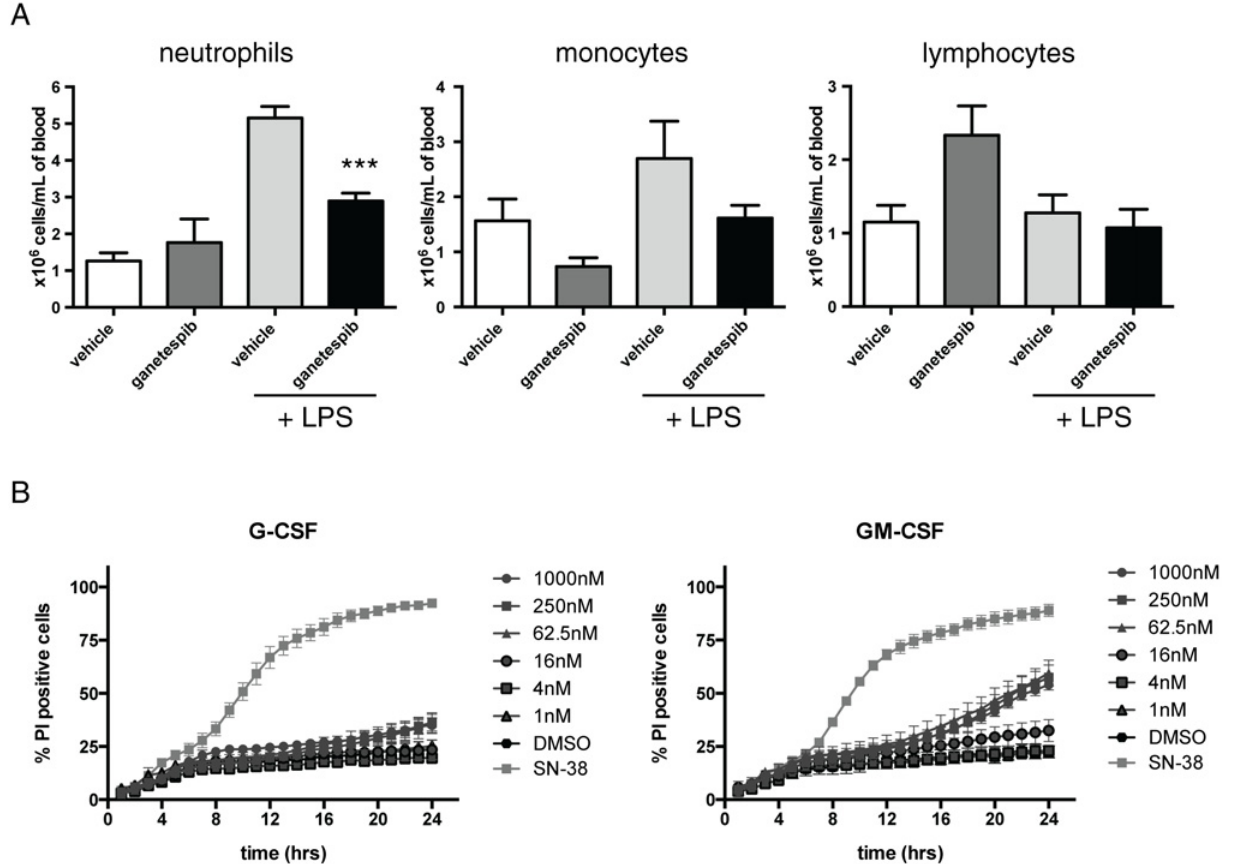
Figure 4. Ganetespib does not suppress basal circulating blood neutrophils but inhibits LPS induced mobilization without causing neutrophil apoptosis. Balb/c mice were treated with ganetespib (100 mg/kg, i.v. or vehicle) and challenged with LPS (10 µ g/mouse tn). (A) 24 h post-LPS peripheral blood counts and blood smears were obtained. Smears were manually differentiated into neutrophils, monocytes and lymphocytes. Total leukocytes were quantified and differentiated using standard morphological criteria of fixed and stained blood smears. Data are mean ± SEM. n = 6 – 8 mice per group (n = 3 for ganetespib alone). Note that ganetespib did not significantly reduce basal neutrophil numbers but suppressed mobilization post-LPS. (B) Kinetic profile of the effect of ganetespib on neutrophil survival as assayed by live cell imaging. Neutrophils were treated with ganetespib, (concentrations as shown) or 10 µ M SN-38 (positive control), for 15mins before addition of 10ng/mL G-CSF or GM-CSF. Data points represent means +/- SEM of three independent samples. p < 0.001 for SN-38 vs DMSO from 8h in G-CSF and GM-CSF-treated cells. p < 0.05 for 250nM GIB vs DMSO at 24h in G-CSF-treated cells. p < 0.05 for